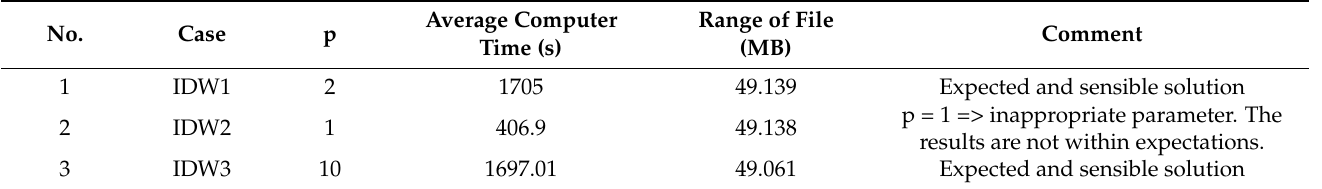
Table 2. Results of IDW interpolation.